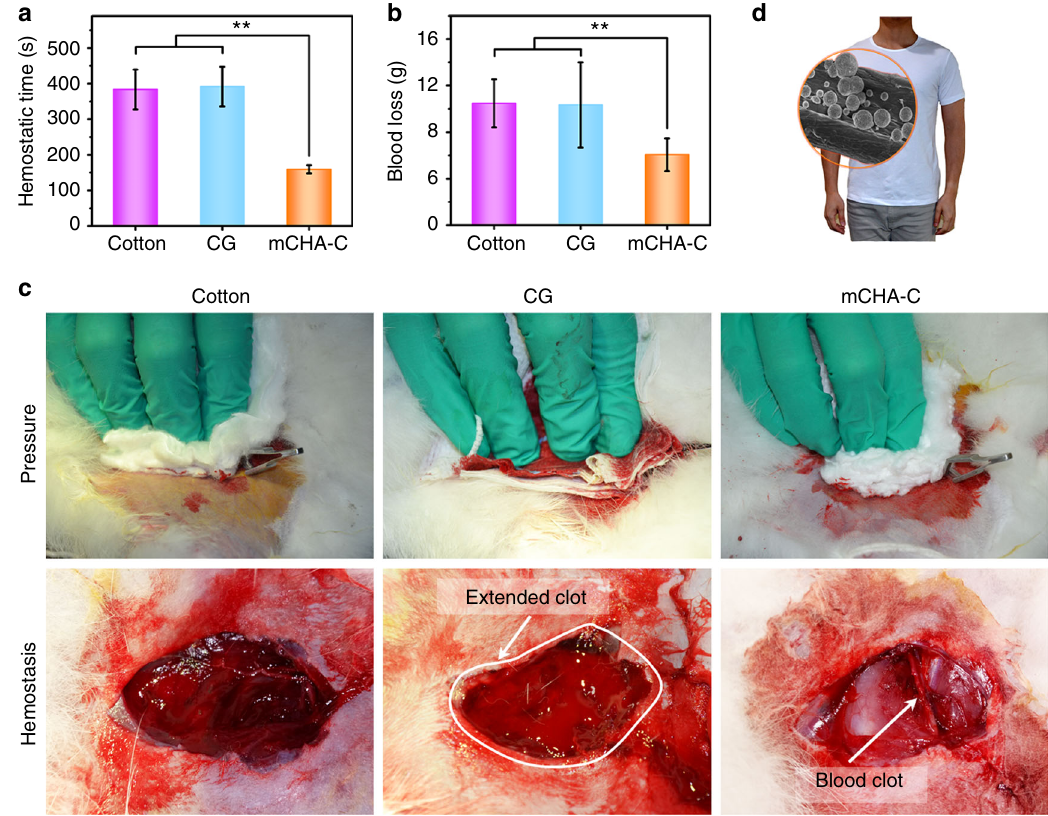
Fig. 4 In vivo hemostatic capacity evaluation of hemostats. Quantitative analysis of hemostatic time ( a ) and blood loss ( b ) in the rabbit femoral artery injury model. Source data are provided as a Source Data fi le. Data values corresponded to mean ± standard deviation (SD), n = 8. Error bars represent SD. ** P < 0.01, one-way analysis of variance (ANOVA). c Hemostasis was assessed upon manual pressure on the rabbit lethal femoral artery injury with cotton (left), CG (mid), or mCHA-C (right). d Image of